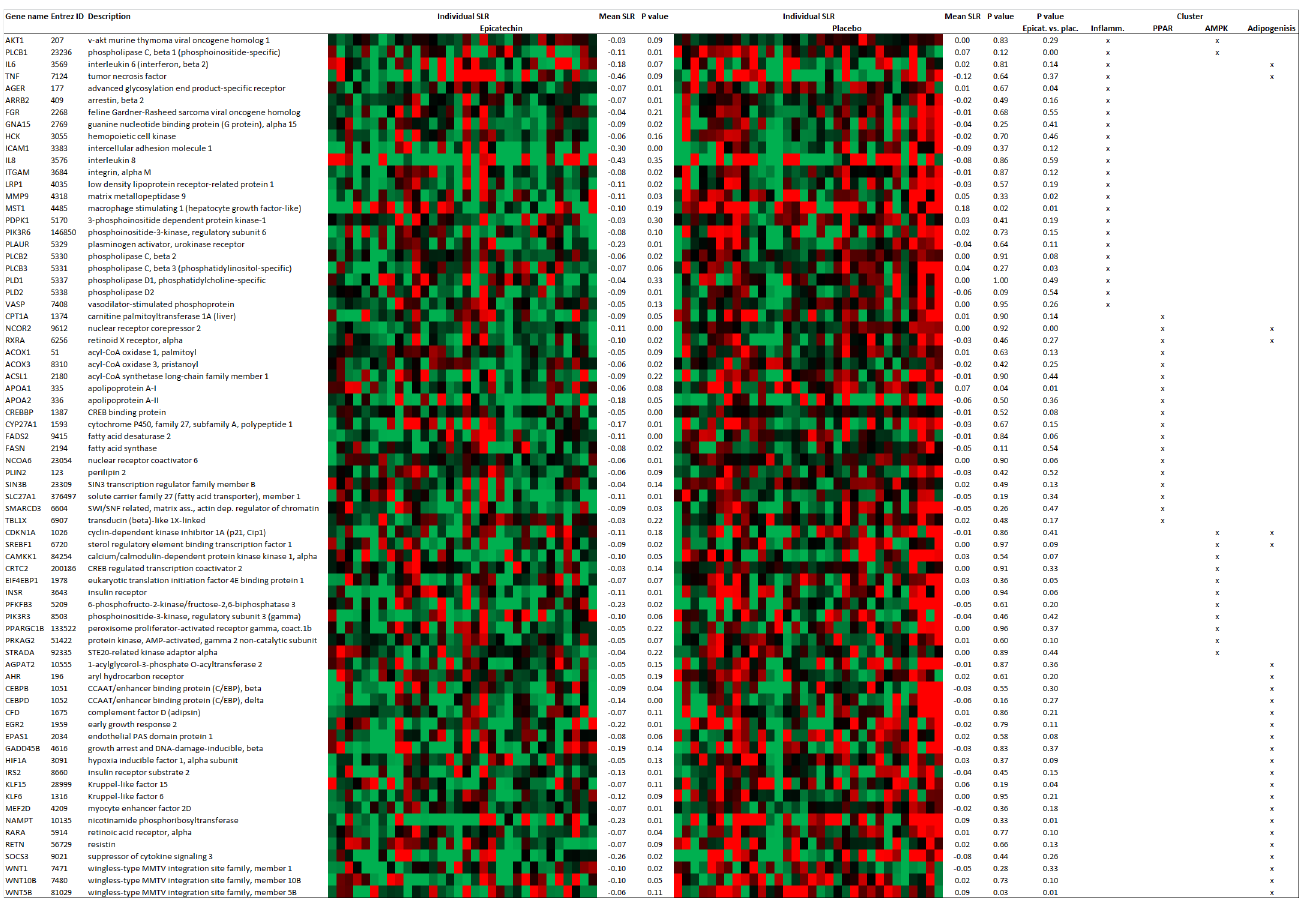
Fig 3. Expression heat map of contributing genes within the downregulated gene sets involved in inflammation, PPAR signalling, AMPK signalling and adipogenesis. Subjects were hierarchically clustered via the complete agglomeration method. Expression changes are indicated as individual signal-log-ratios (SLR) of T = 4 weeks versus T = 0 weeks. Down-regulation or up-regulation of gene expression is presented on a colour scale, ranging from green (downregulated, SLR (cid:20) -0.25) to red (upregulated, SLR (cid:21) 0.25).